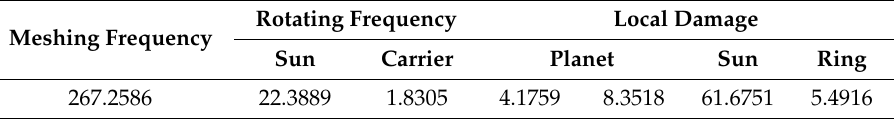
Table 5. Characteristic frequencies (Hz).